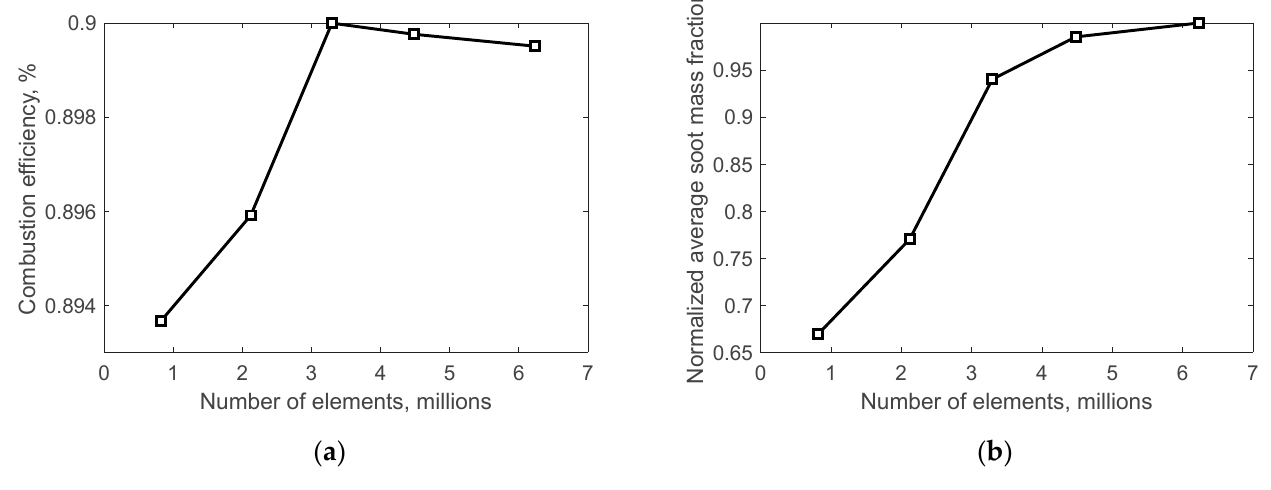
Figure 3. Results of mesh sensitivity study: ( a ) combustion e ffi ciency; ( b ) normalized soot mass frac- tion.